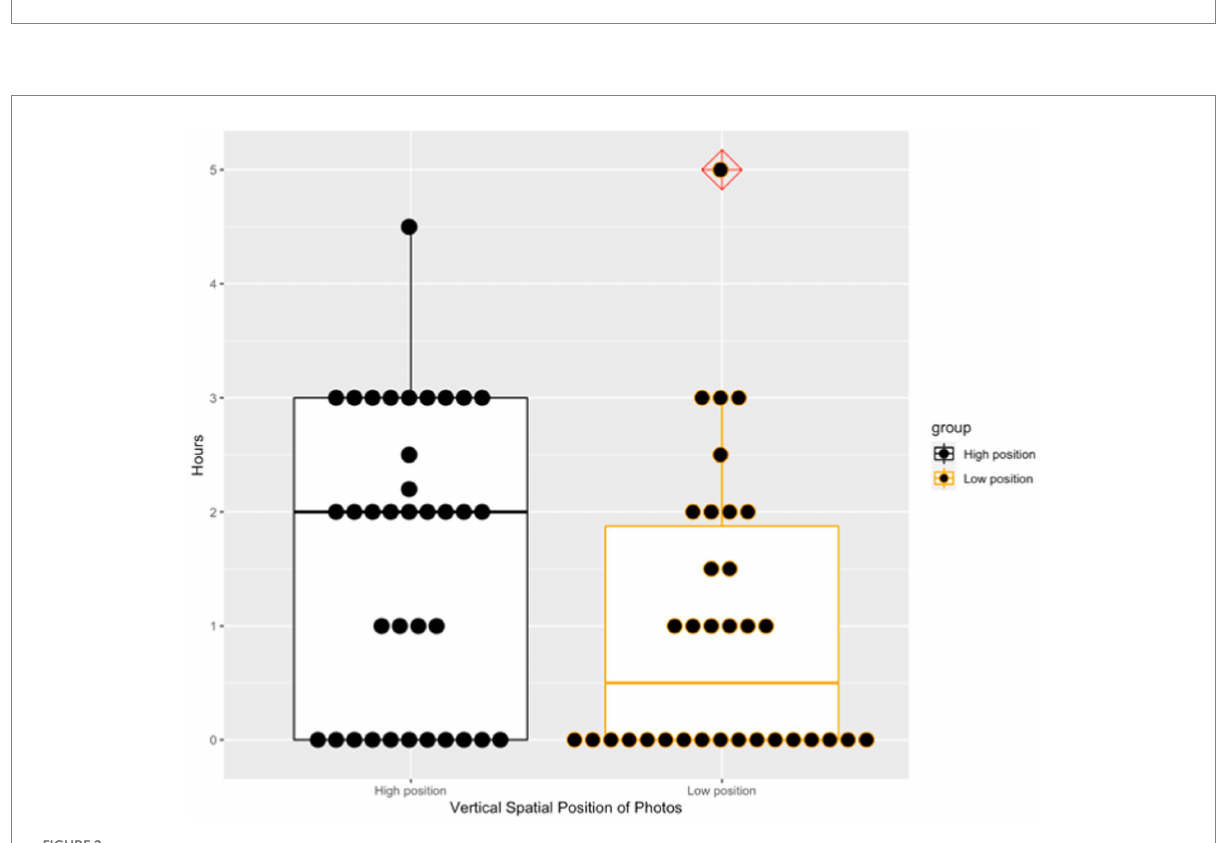
FIGURE 2 Two groups’ helping hours in Study